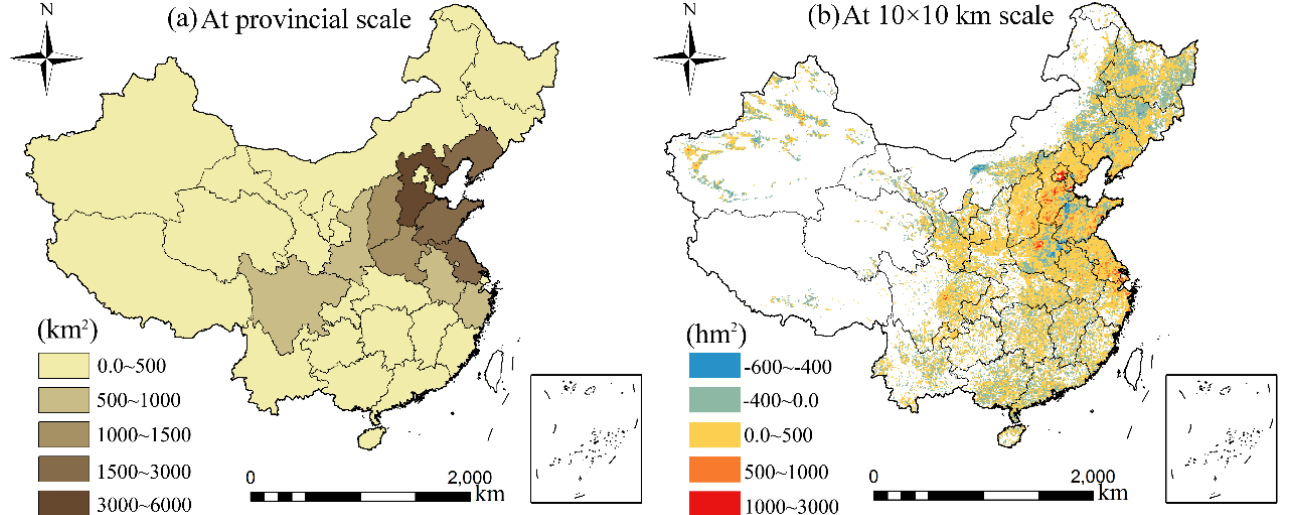
Figure 4. Spatial distribution of the loss of farmland area due to rural settlement expansion from 2000 to 2020.